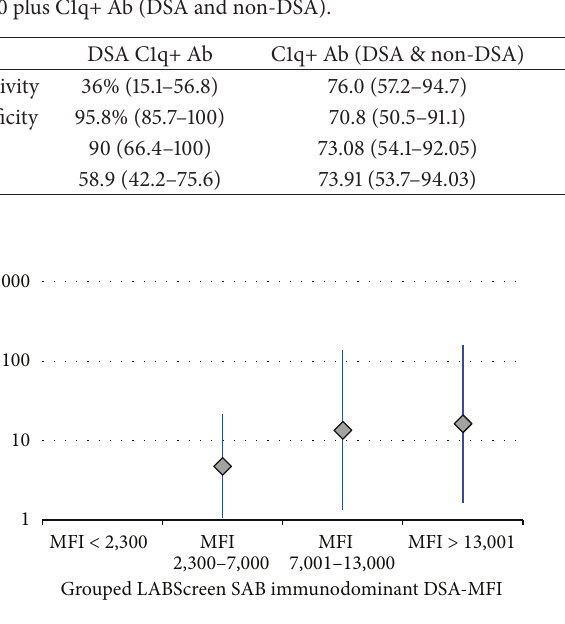
Figure 2: Association of the immunodominant DSA LABScreen SAB MFI with FXM result (logistic regression analysis, expressed odds ratio with 95% confidence interval). DSA w/MFI < 2,300 = reference; MFI 2,300–7,000 = OR 4.75, 1.05–21.35, and 𝑃 = 0.042 ;